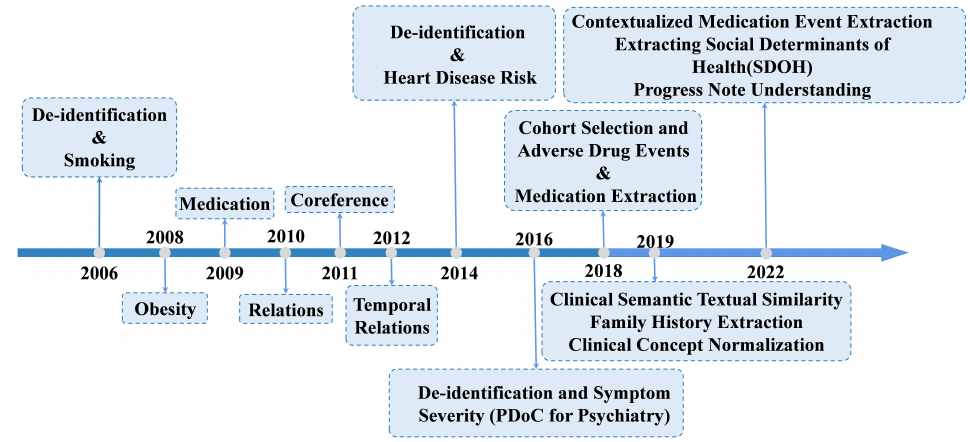
Figure 3. Shared tasks published by i2b2/n2c2. Since 2018 the i2b2 project ended the name was changed to n2c2. For each share task, a high-quality dataset has been officially published.